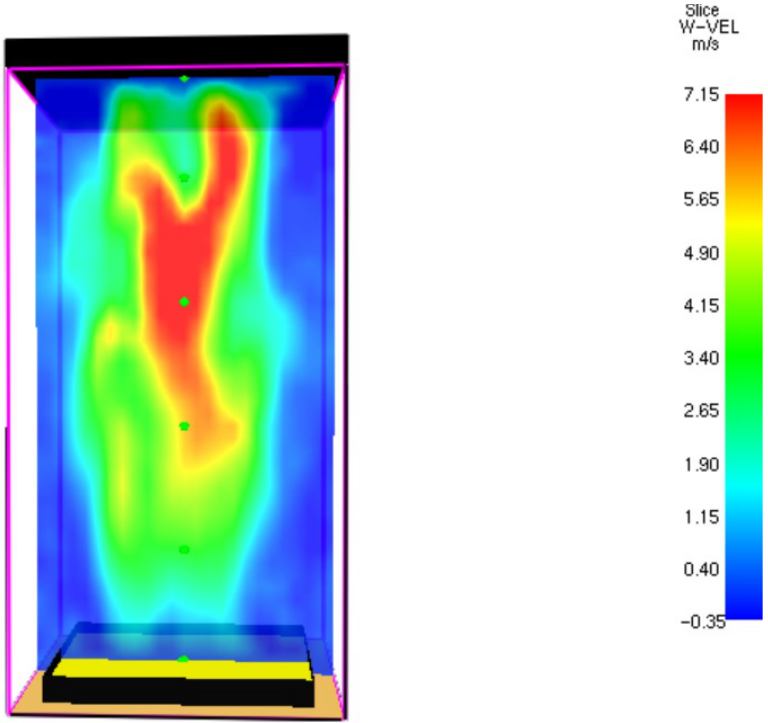
Figure 19. Velocity field (m/s) of the flue gases at t = 80.5 s.